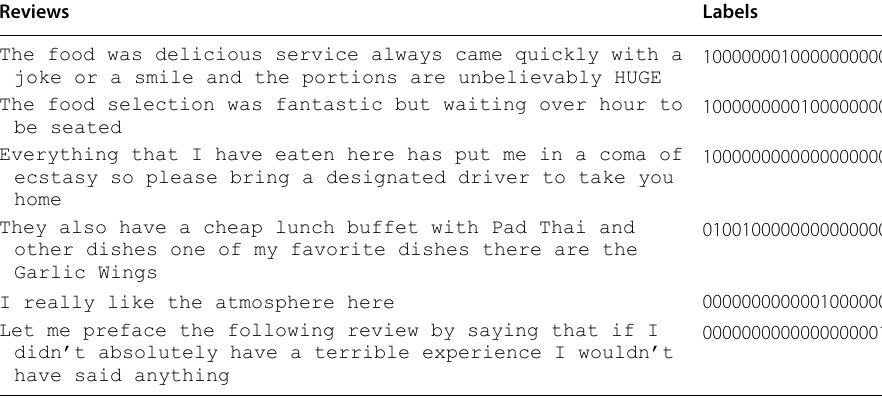
Table 1 Examples of reviews and labels in multi-label ABSA Reviews